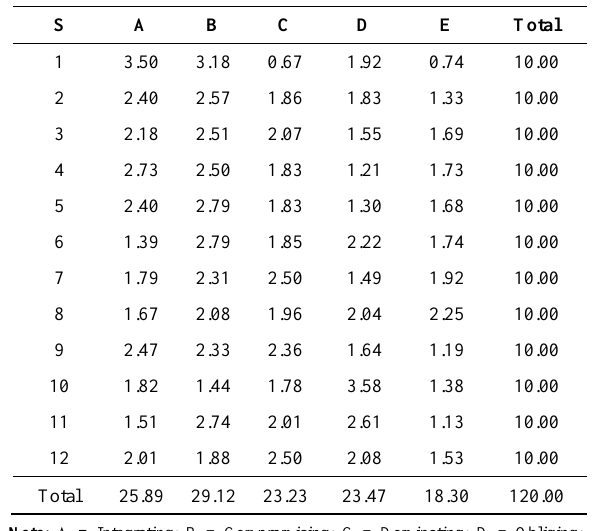
Table 2. Scoring form for the private